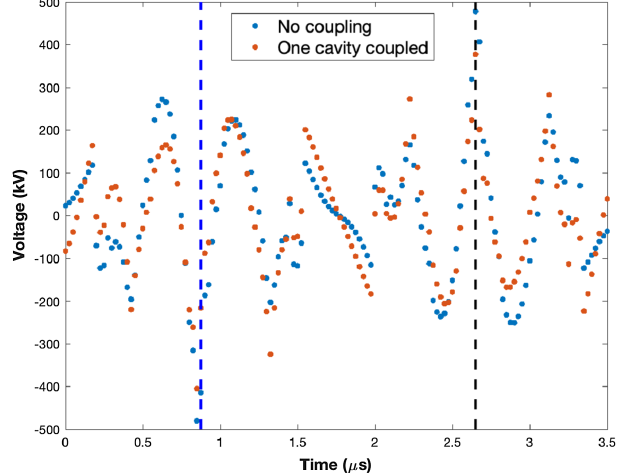
FIG. 14. Uncompensated beam loading with coupled feedback (three-section cavity only). The feedforward is also on. The batch is indicated with vertical dashed lines.